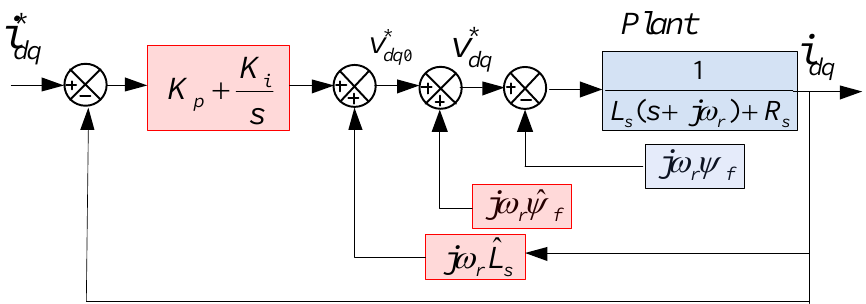
Figure 3. Block diagram of the conventional continuous current controller with state feedback 174 decoupling. 175